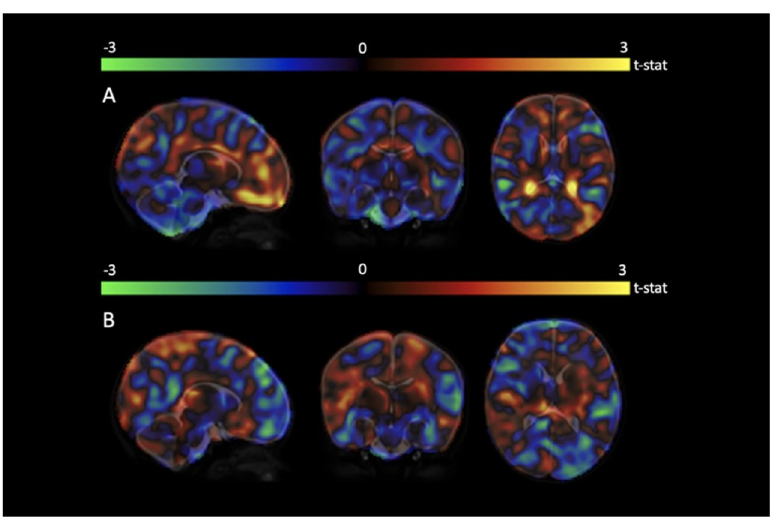
Fig 3. T-statistic maps showing the relationships between voxel-wise log-Jacobian determinants and (a) maternal trait anxiety and (b) stressful life events.